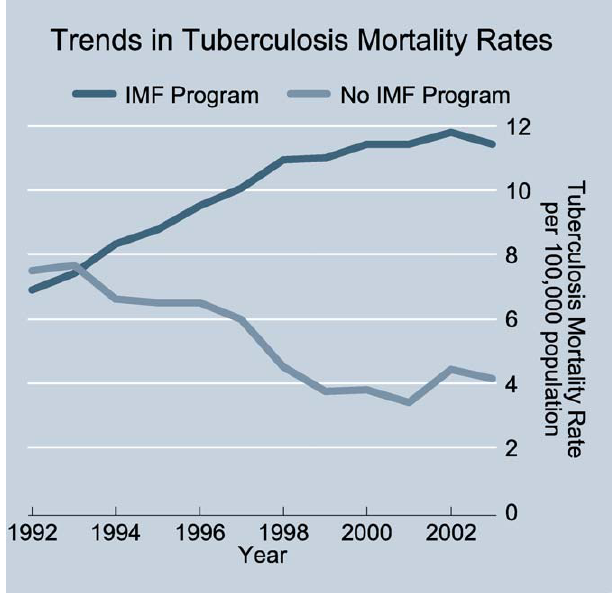
Figure 1. Trends in Tuberculosis Mortality Rates in Post-Communist European Countries, By Region Data sources: authors’ calculations, WHO Global Tuberculosis Database 2007 [20], and World Bank World Development Indicators 2005